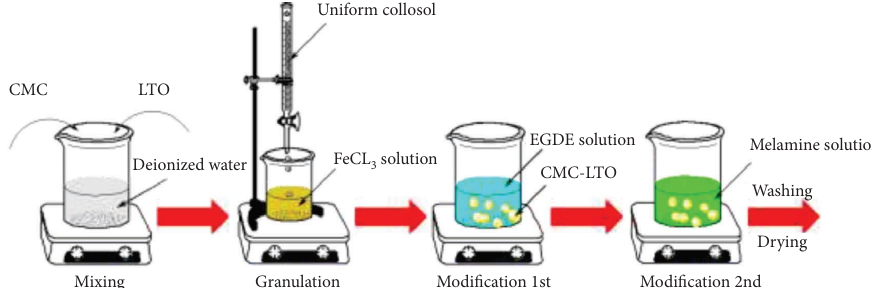
Figure 2: Schematic presentation of CMC-LTO-EGDE-ME microsphere preparation procedure.